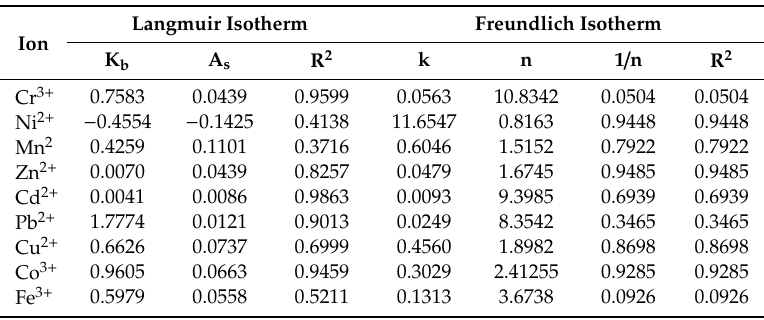
Table 10. The Langmuir and Freundlich isotherms of P (AA / Kry23-DM) SAP and the poly(AA-co-Kry22- DM) SAP for the heavy metal ions.